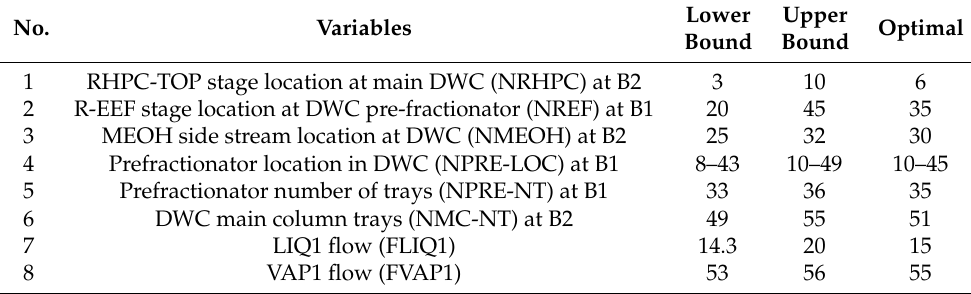
Table 3. Optimization variables and